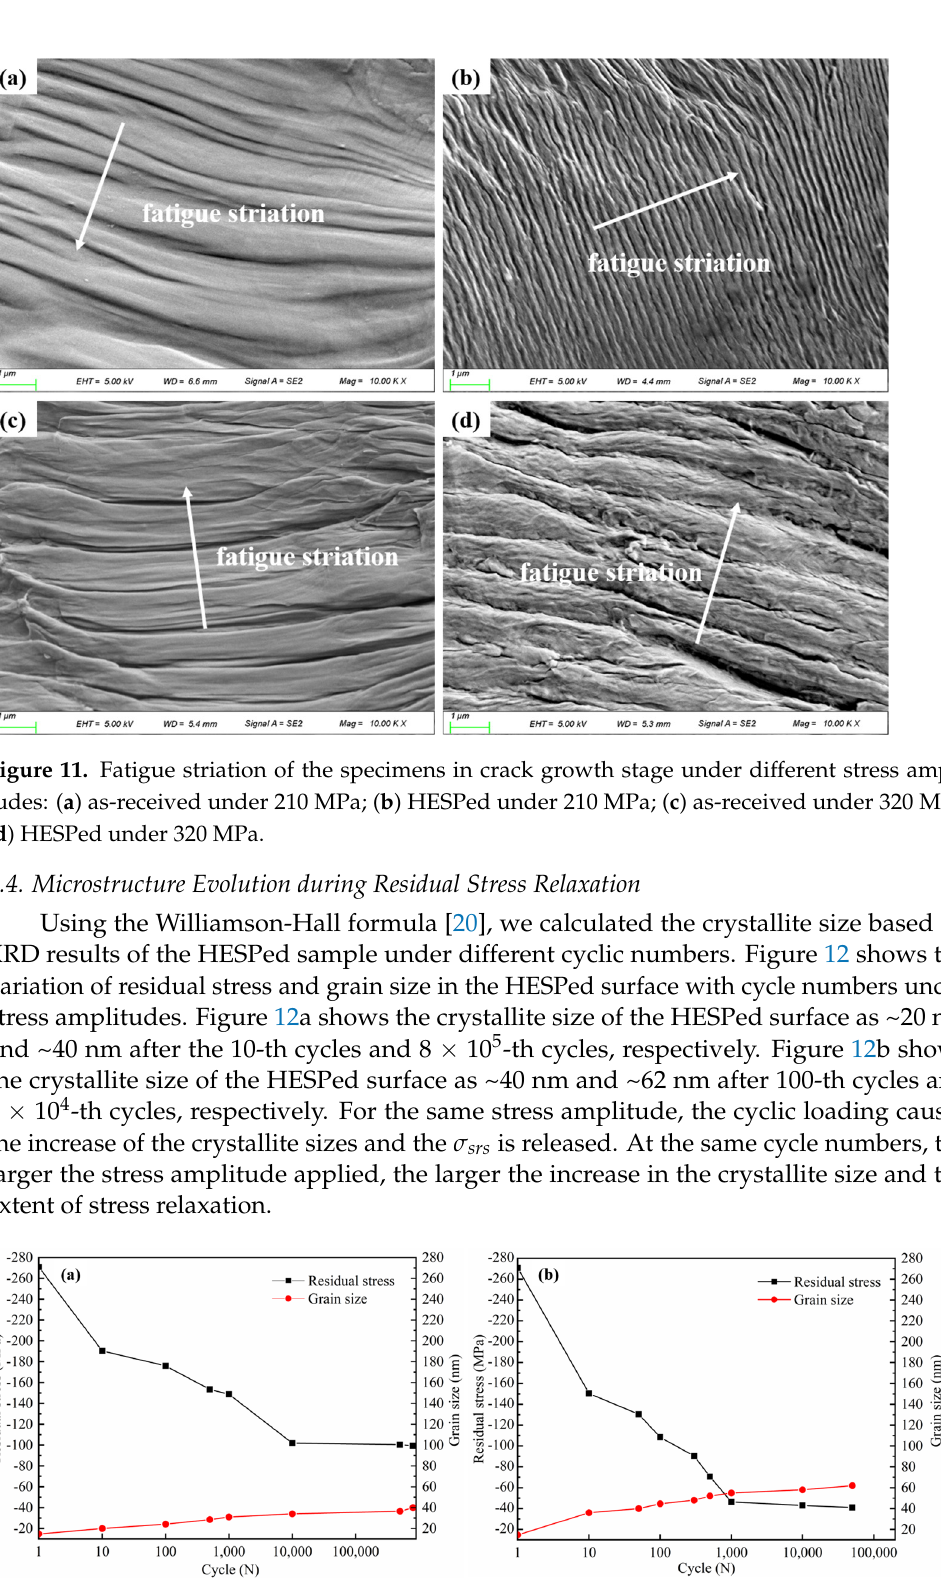
9 of 13 Figure 10. Residual stress at the surface vs. number of cycles at different stress amplitudes: ( a ) nor- mal cycles; ( b ) logarithm of cycles. Figure. 11 shows the fracture morphologies of the samples in the fatigue crack zone stage under different stress amplitudes. The numerous microscopic plastic deformation traces are parallel with each other, as pointed by white arrow in Figure 11. The trace is known as fatigue striation. Figure 11a,b shows the fatigue striations of the as-received and the HESPed specimens under stress amplitude of 210 MPa. The average fatigue striations spaces are 0.51 μ m and 0.25 μ m, respectively. Figure 11c,d shows the fatigue striations of the as-received and the HESPed specimens under stress amplitude of 320 MPa. The aver- age fatigue striations spaces are 0.97 μ m and 0.75 μ m, respectively. The width of fatigue striation space corresponds to the crack propagation rate. The